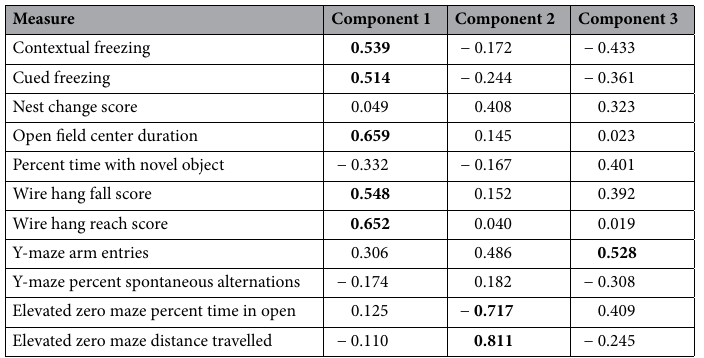
Table 1. Principal components analysis: component loadings for behavioral and cognitive measures. Loadings higher than 0.500 are in bold.